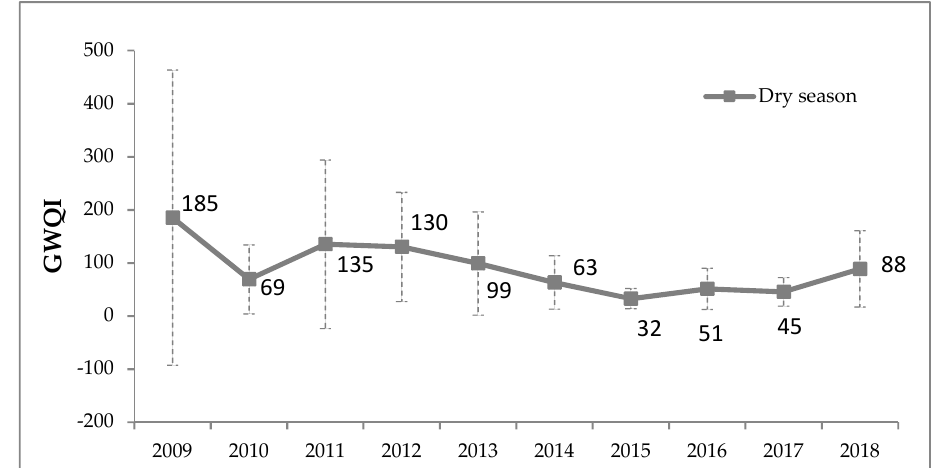
Figure 5. The average of GWQI units of eight wells in the dry season, during 2009–2018.